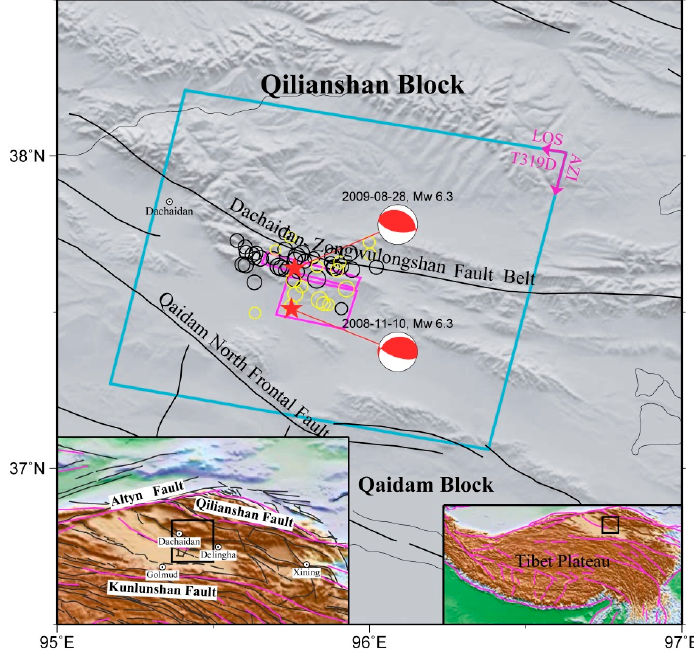
Figure 1. Tectonics associated with the 2009 Mw 6.3 DCD earthquake. The bottom-left and bottom-right insets show the location of the main figure, respectively. The light blue rectangle is the spatial extent of